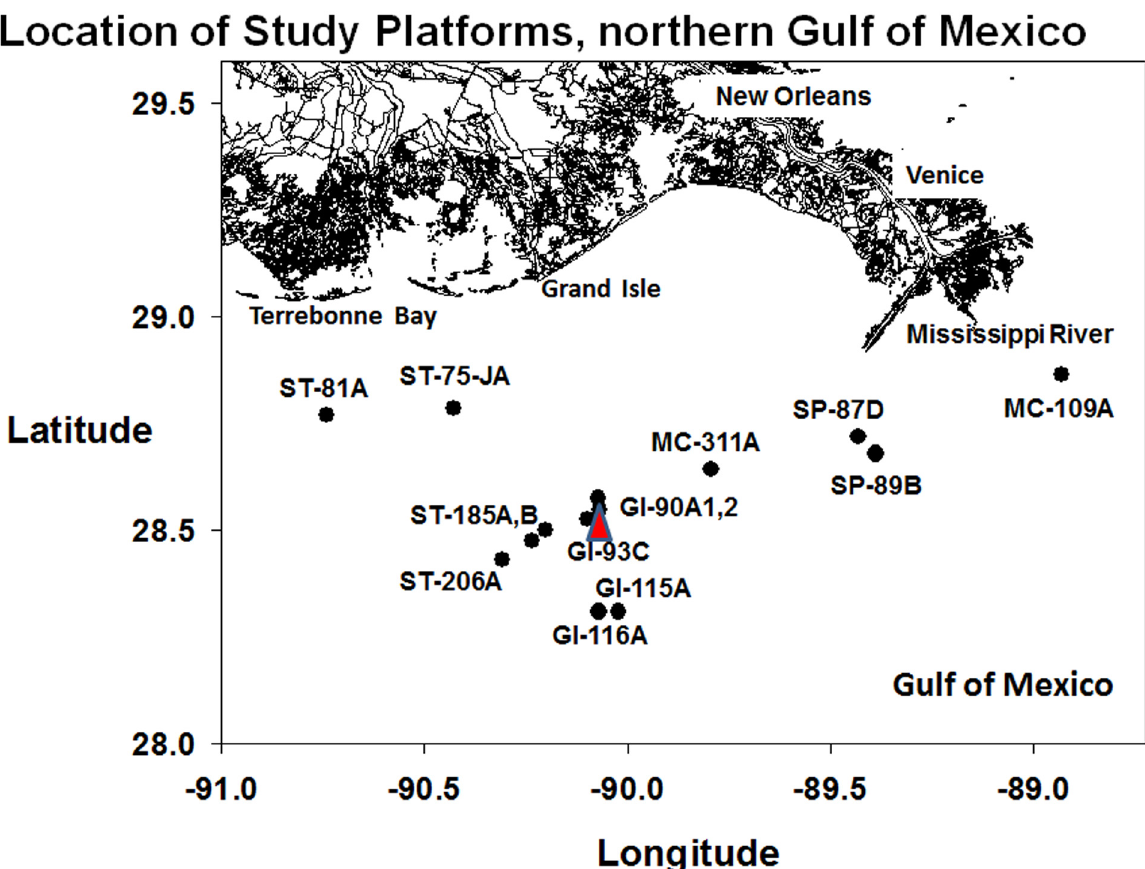
Fig 1. A map of all platforms surveyed by ROV during this study. Platform code and position shown. Point of first sighting (2007) shown as a triangle (GI-